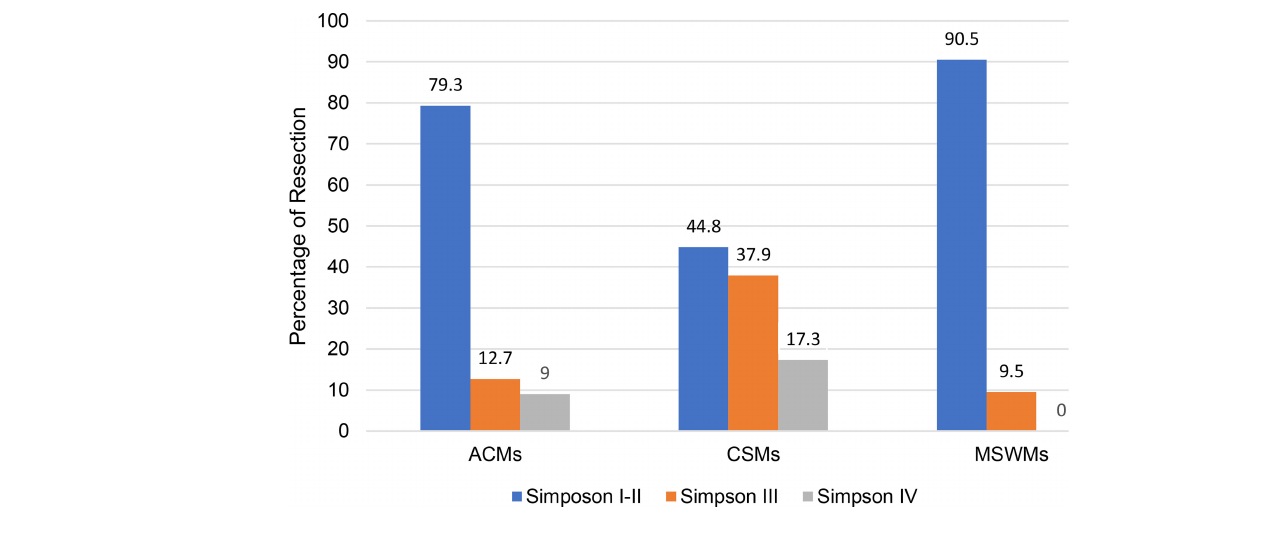
TABLE 2 | Bar graph showing the extent of resection in three